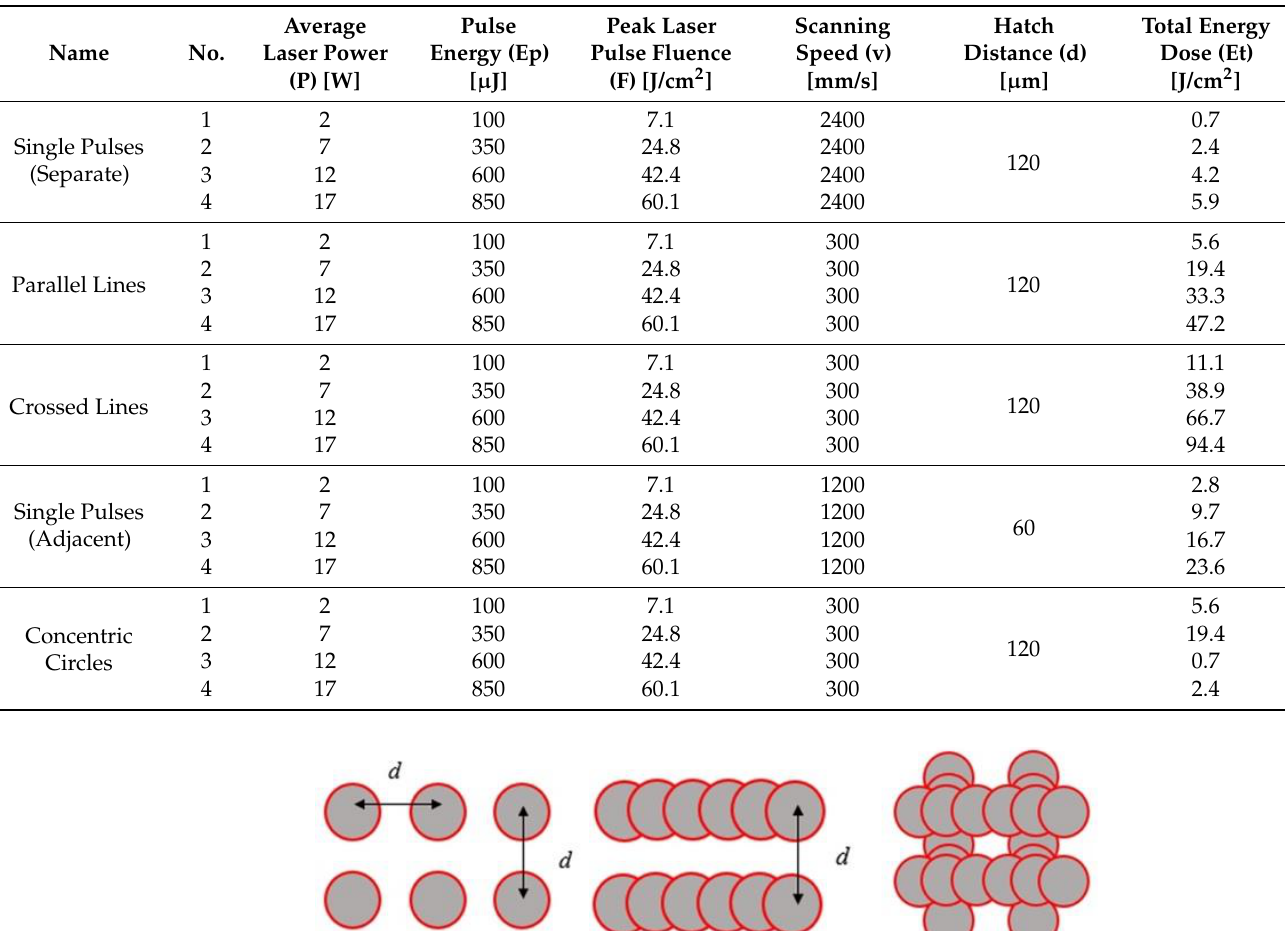
Table 1. Summary of laser processing parameters employed for experiments.